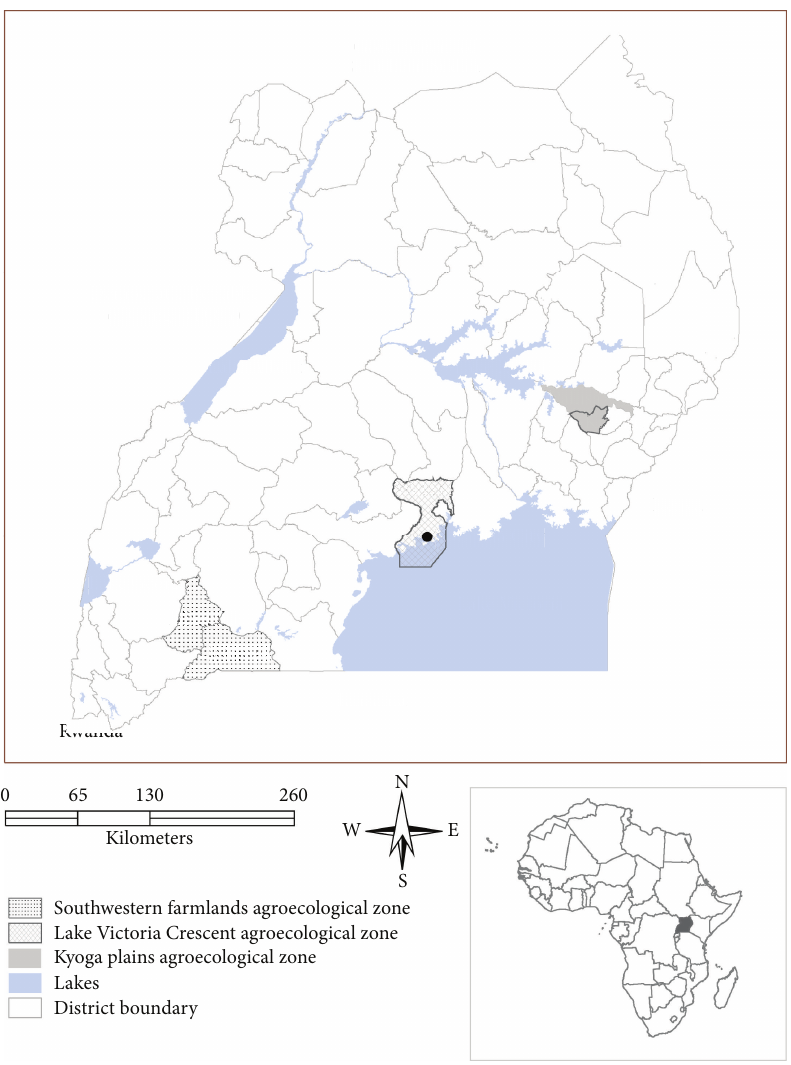
Figure 1: Map of Uganda showing the study